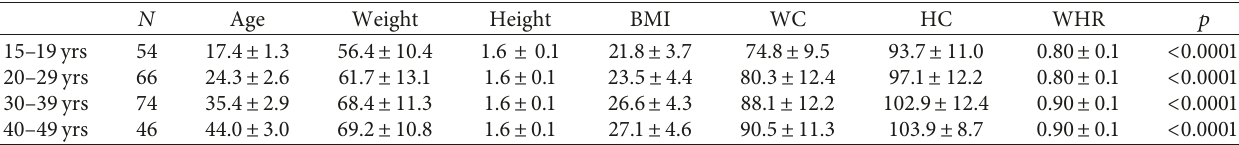
Figure 1: Overweight and obesity of women enrolled in the study. (a) BMI (kg/m 2 ). (b) WHR (cm). Table 3: Anthropometric parameters of participants by age